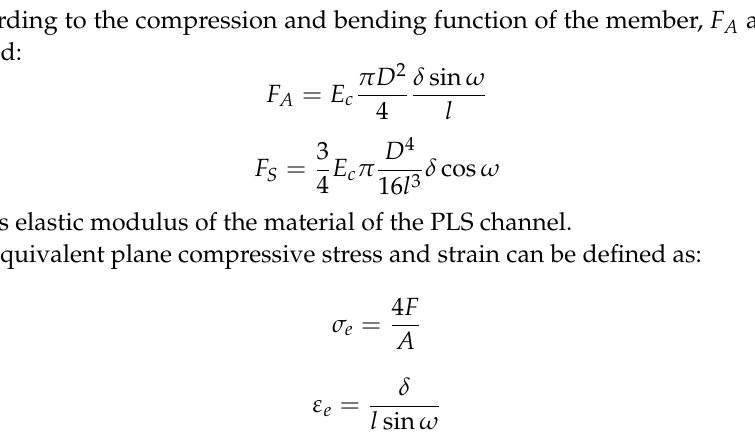
Figure 4. Force analysis of single member of PLS